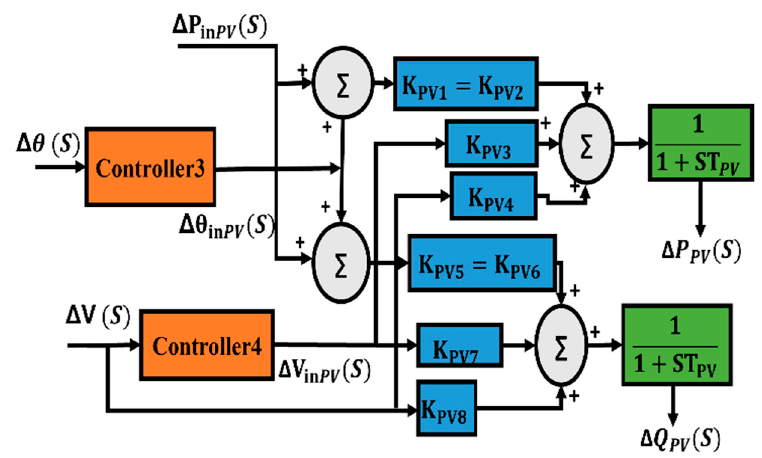
Figure 4. SLD of SPVS.